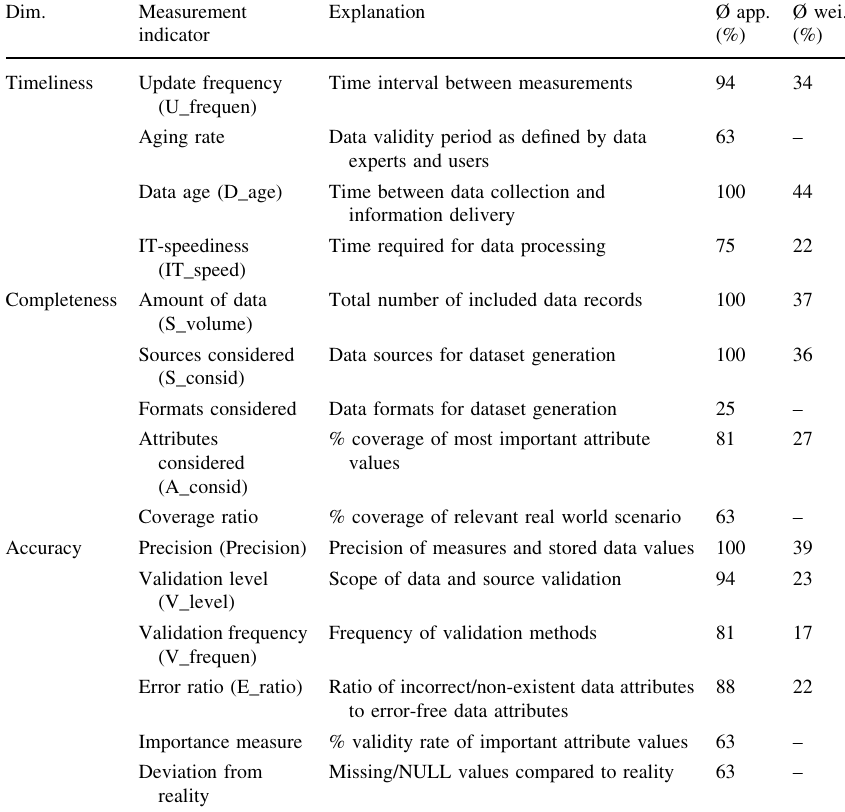
Table 4 Derived measurement indicators of the information quality criteria